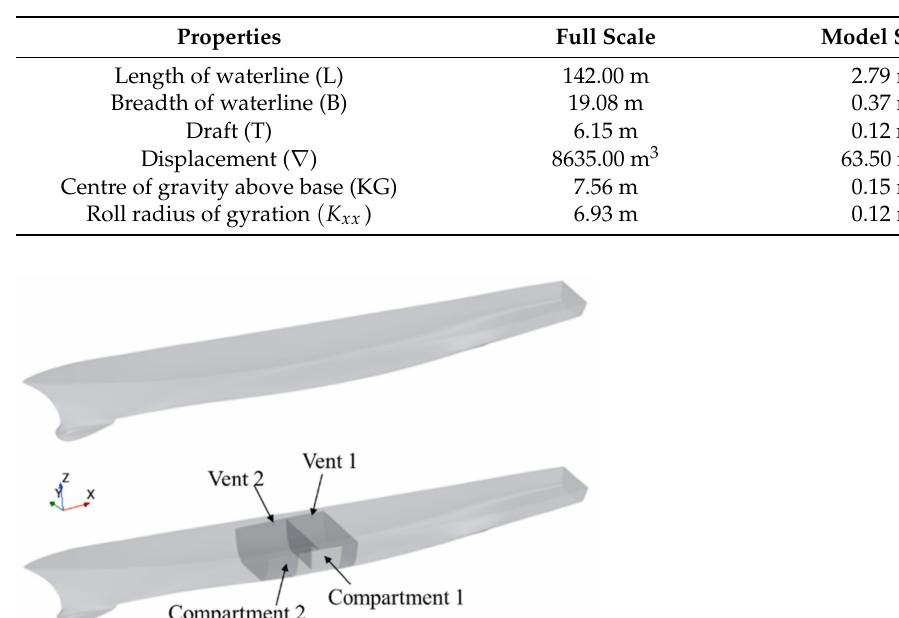
Table 1. Parameters for the DTMB 5415 in the intact condition.